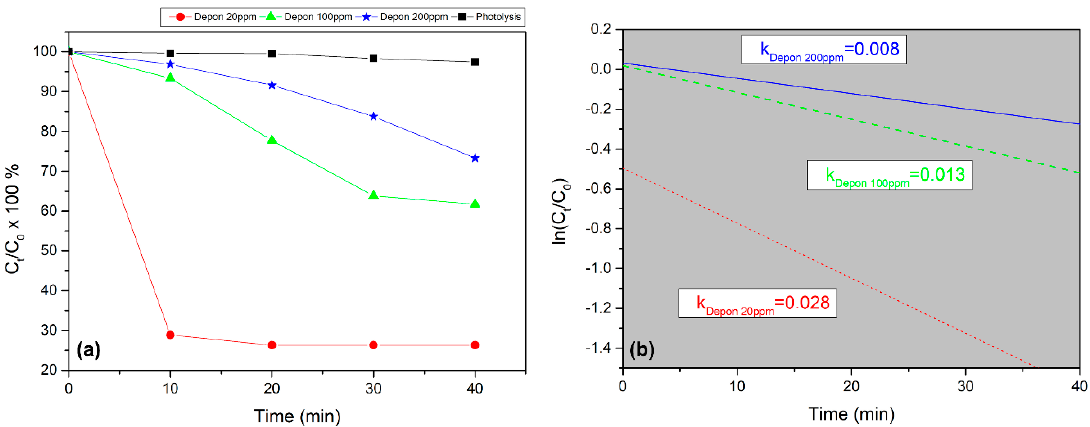
Figure 5. ( a ) % APAP degradation using 40% w/w 3D-printed TiO 2 /PS nanocomposites under UV-A irradiation, vs. irradiation time. Three different concentrations of APAP are presented; 20 ppm, 100 ppm and 200 ppm (red solid circles, green solid triangles and blue solid stars, respectively). ( b ) The apparent rate constants (k) of APAP degradation (20 ppm, 100 ppm, and 200 ppm, respectively), using 40% w/w 3D printed TiO 2 /PS nanocomposite photocatalysts.